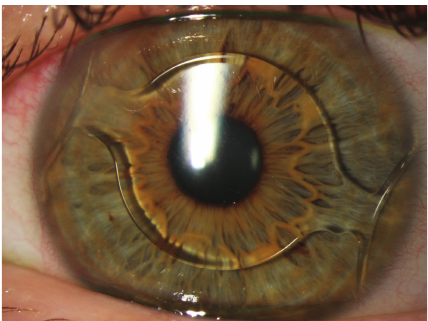
Figure3:Typicalslitlampfindingsonthefirstdayafterimplantation of an AcrySof Cachet showing minimal inflammatory response. Note the conjunctival injection at the corneoscleral tunnel at 10